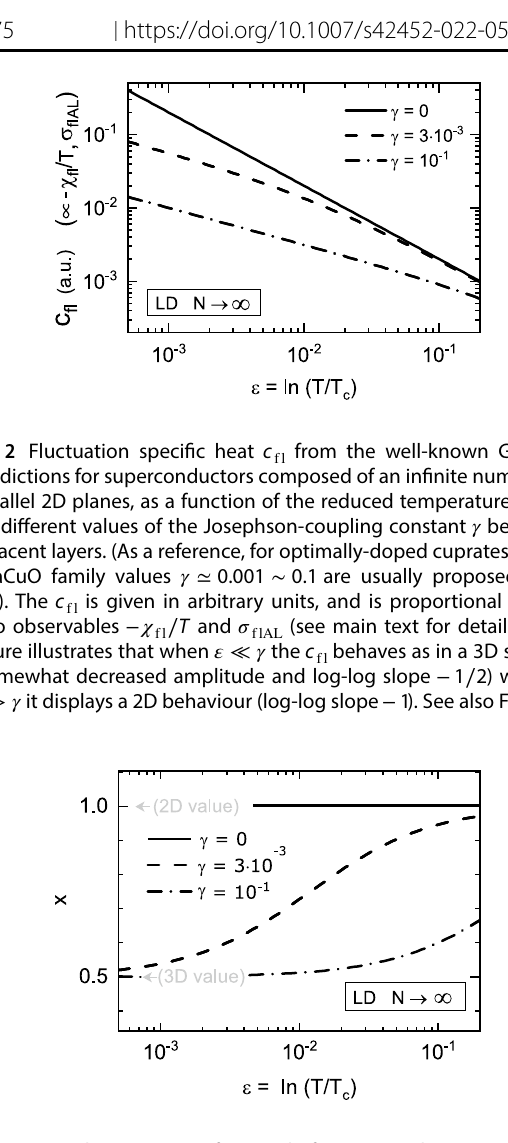
Fig. 3 Critical exponent x of c fl (and of − 𝜒 fl ∕ T and 𝜎 flAL ) resulting from the GGL-LD calculations for infinite-layers superconductors, as a function of the reduced temperature 𝜀 for different values of the Josephson coupling 𝛾 . The figure illustrates the crossover from the 3D value ( x = 1 ∕ 2 ) to the 2D one ( x = 1 ) as 𝜀 evolves from 𝜀 ≪ 𝛾 to 𝜀 ≫ 𝛾 , ant that the dimensional corossover occurrs around 𝜀 ≃ 4 crossover